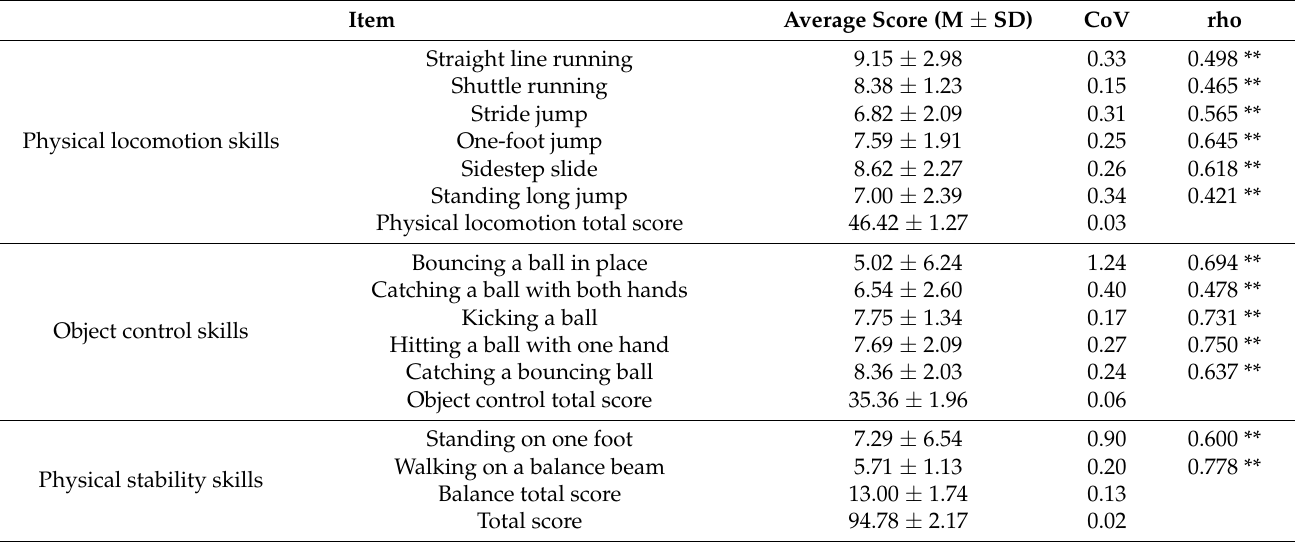
Table 5. Results of testing the preliminary measurement